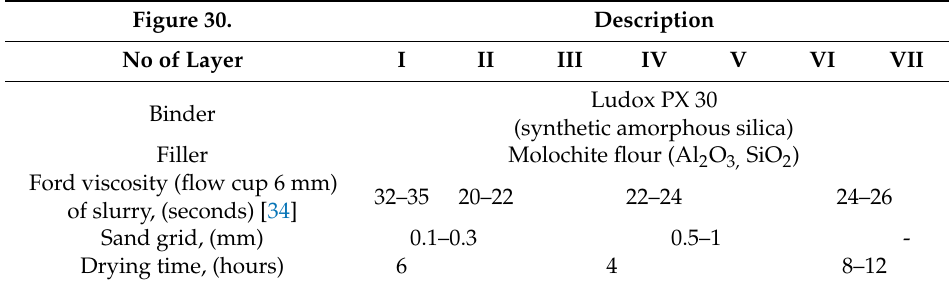
Figure 1. Dimensions of the wax-model.